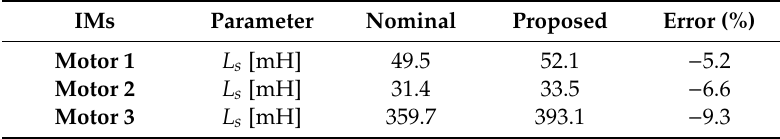
Table 5. Identified Stator Inductances for Motor 1~3